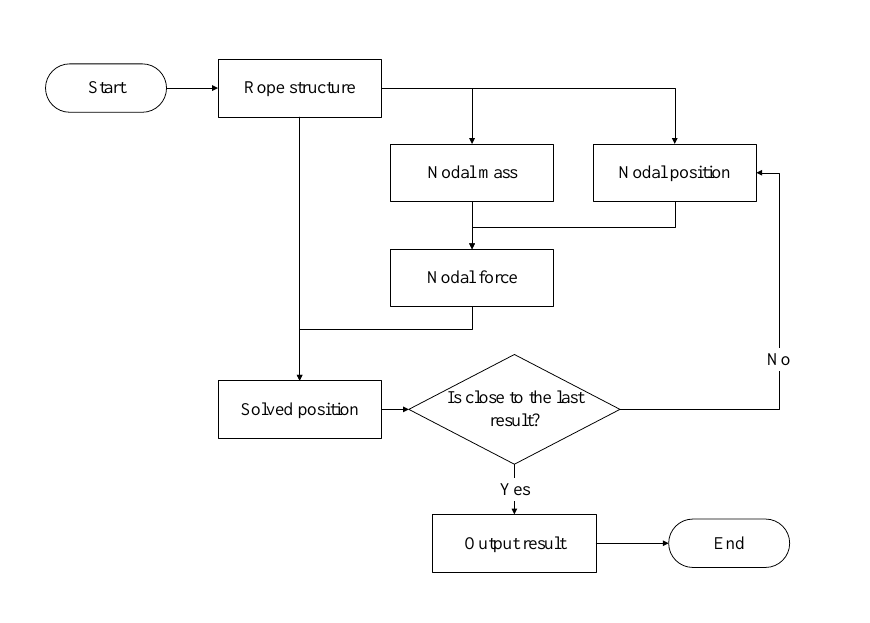
Figure 6. Numerical method for theoretical stress calculation of space elevator